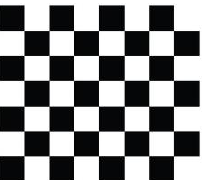
Figure 5. Test field for Camera